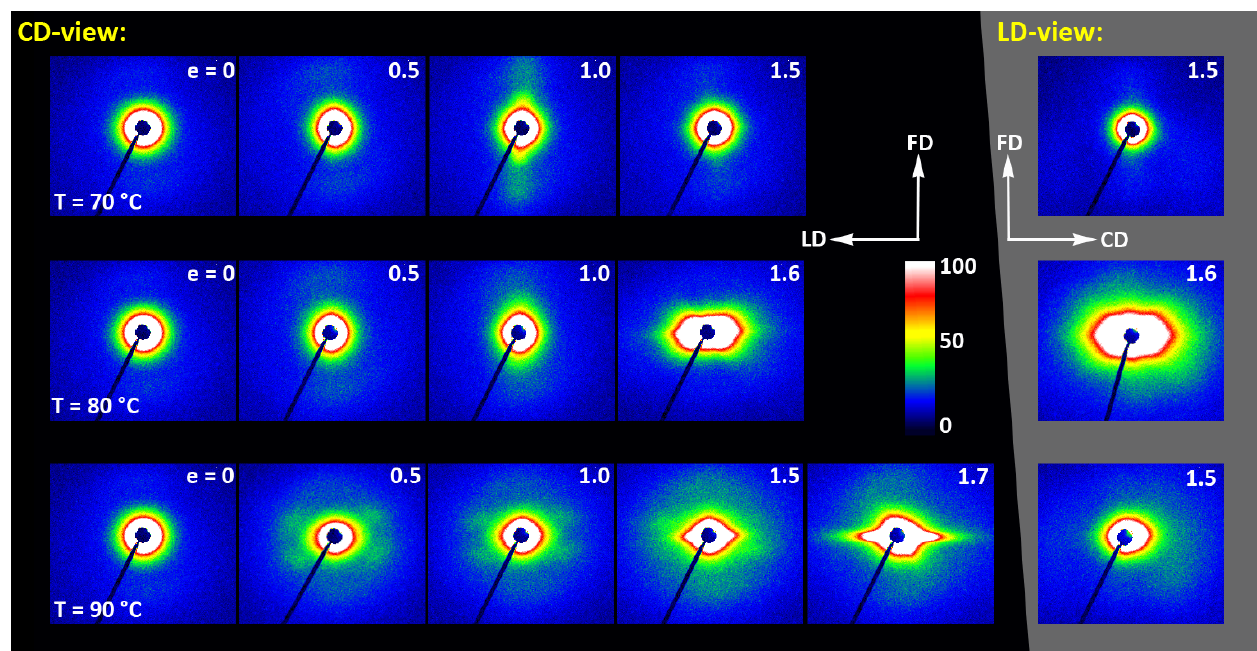
Figure 14. 2D-SAXS patterns of the initially amorphous A samples deformed in the plane-strain compression at temperature T d = 70–90 °C ( rows from top to bottom ), to the indicated true strain. The patterns on the left (black background) were obtained in the CD-view. The patterns in the column on the right (gray background) are LD-view.